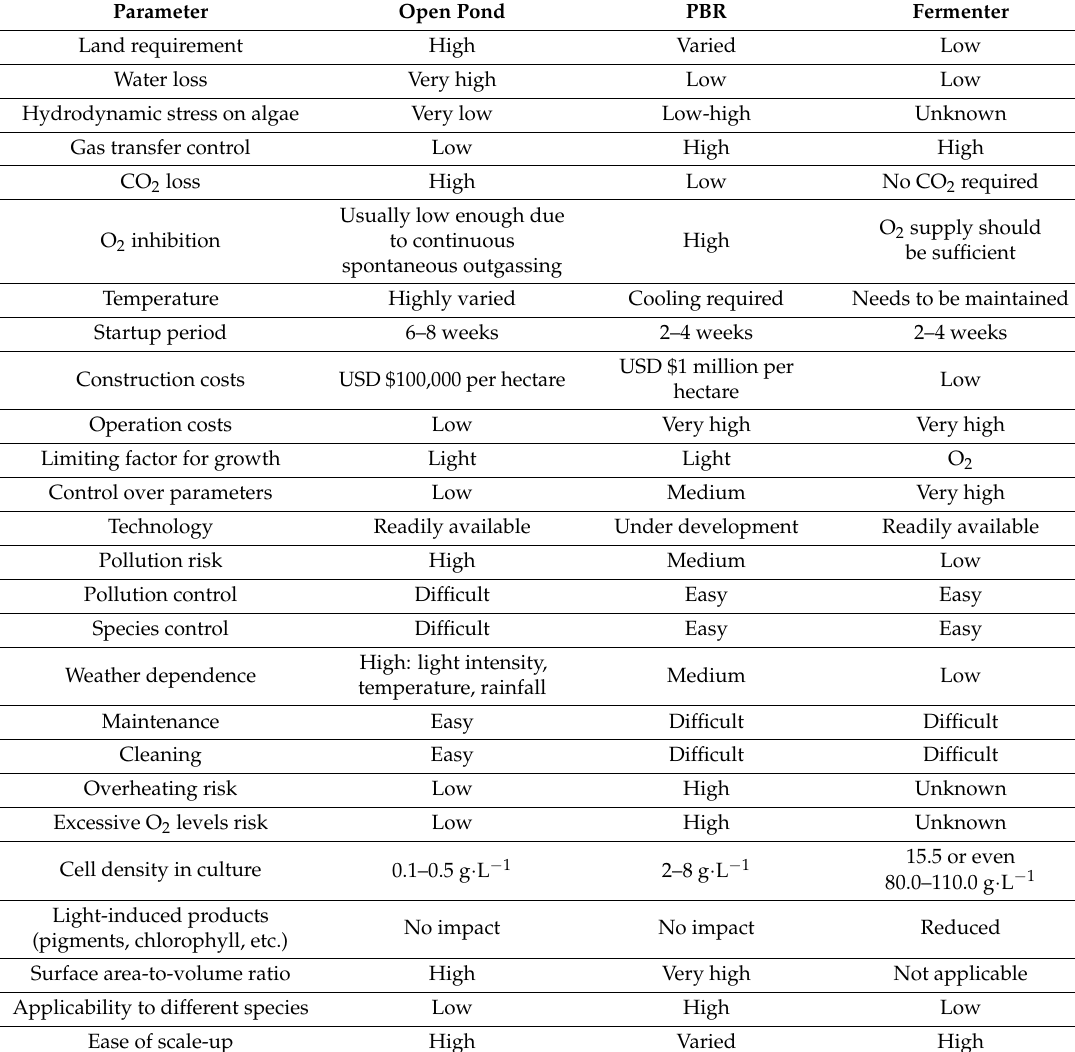
Table 10. Comparison of open ponds, PBRs and fermenters. Used with permission from [201].